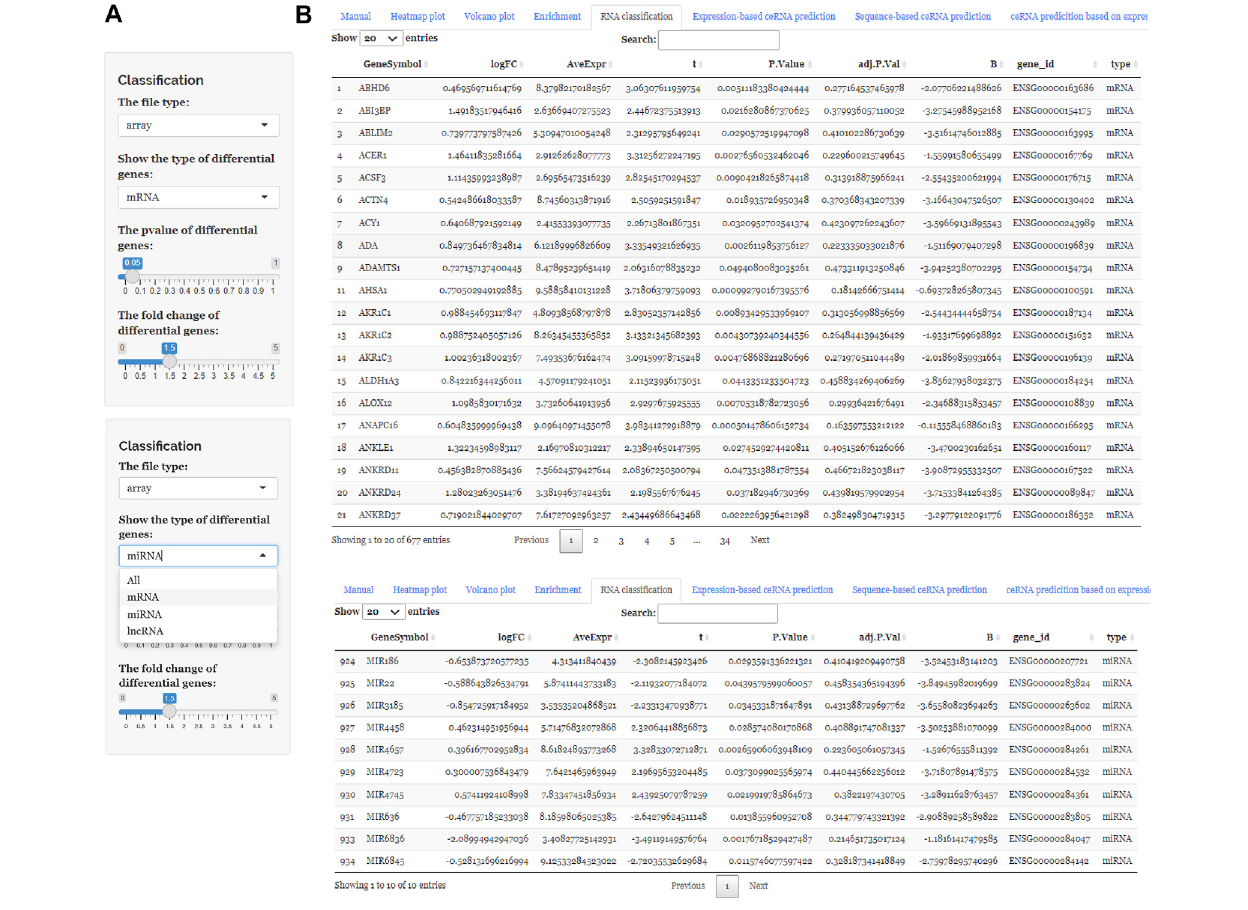
Frontiers in Molecular Biosciences |